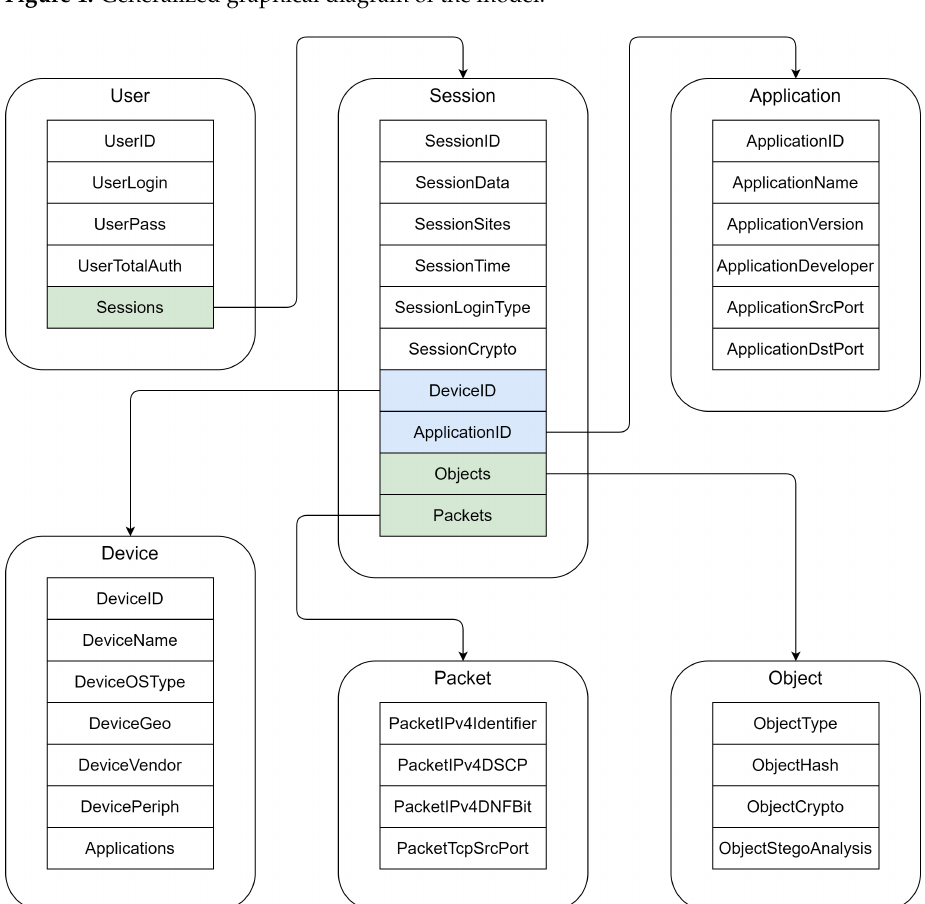
Figure 2. Scheme of database with